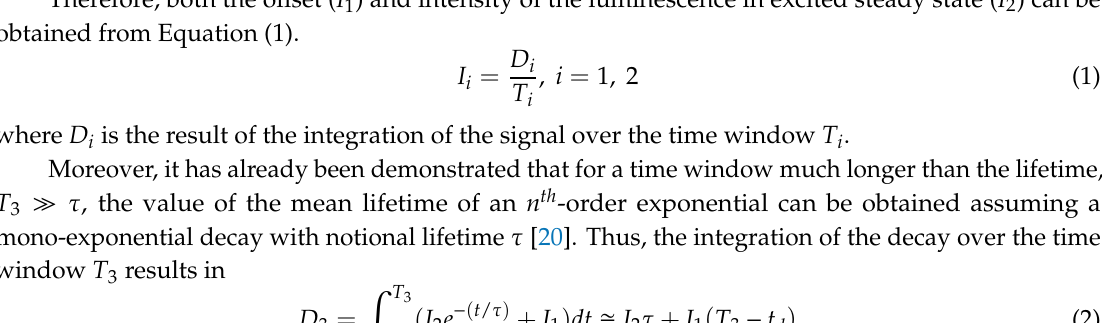
Figure 2. Measurement scheme based on three time windows.